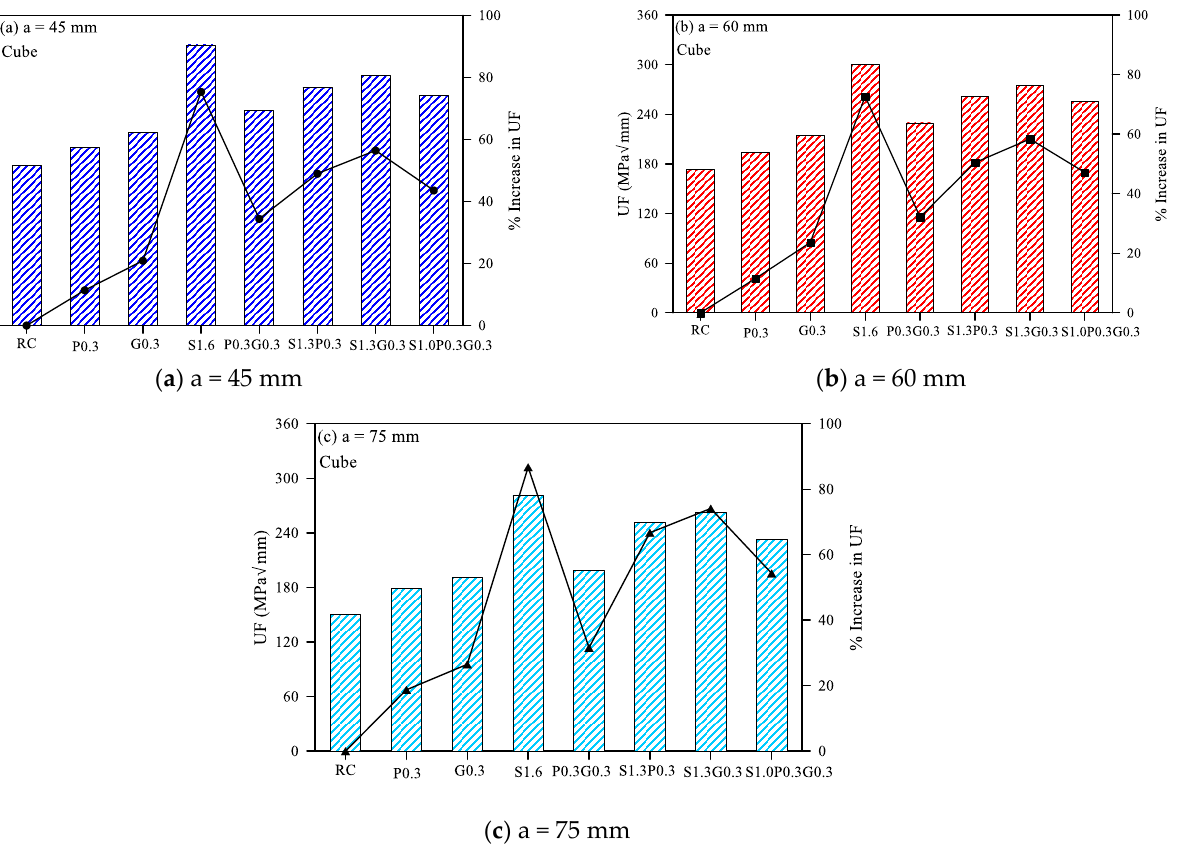
Figure 3. Mode II cube specimens’ fracture energy of the eight geopolymer mixtures.